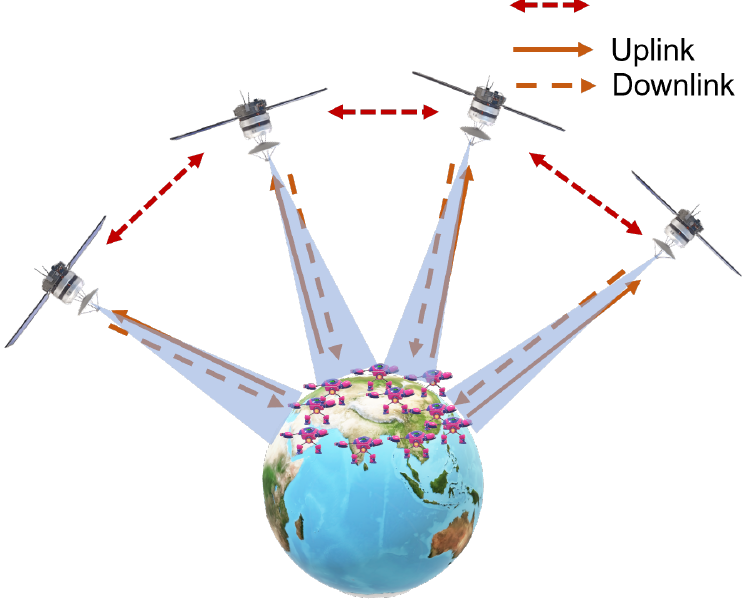
Figure 1. DDoS attacks on LEO satellite network launched from several compromised